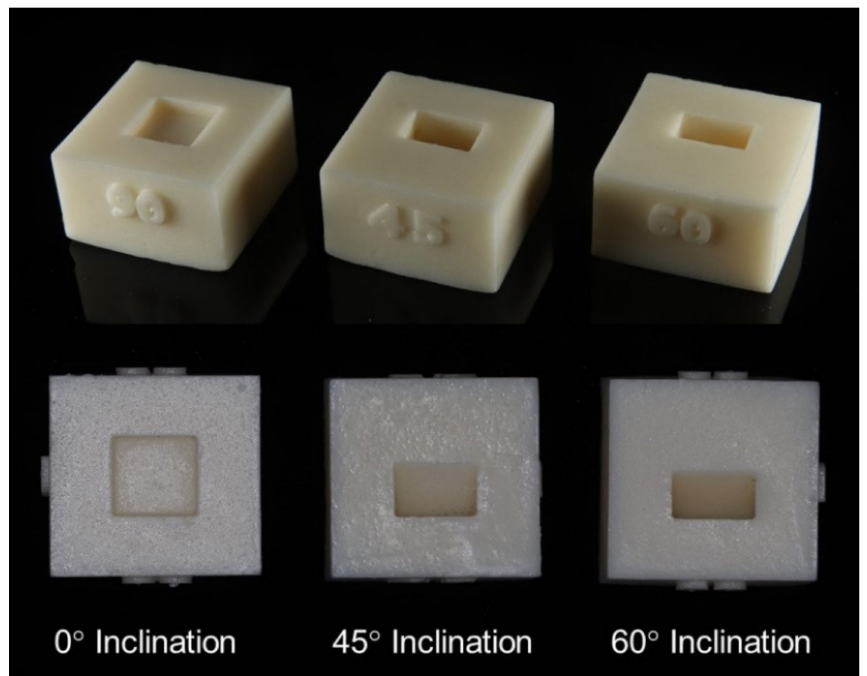
Figure 3. Bone models (oblique view and top view). The guides were obtained from the printer and bone models from the mold. They were bonded together using cyanoacrylate super glue. Then the metal sleeves were inserted inside the guide in surgical guides for the metal sleeve guides (Dentium full guide kit, Nobel guide Nobel Biocare) (Figure